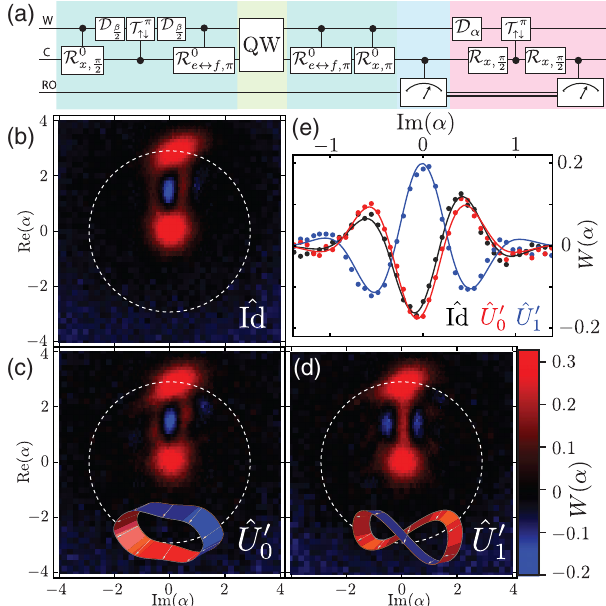
ˆ U 1 ffiffiffi p ¯ n Im ð α Þ þ ϕ (cid:4) ,